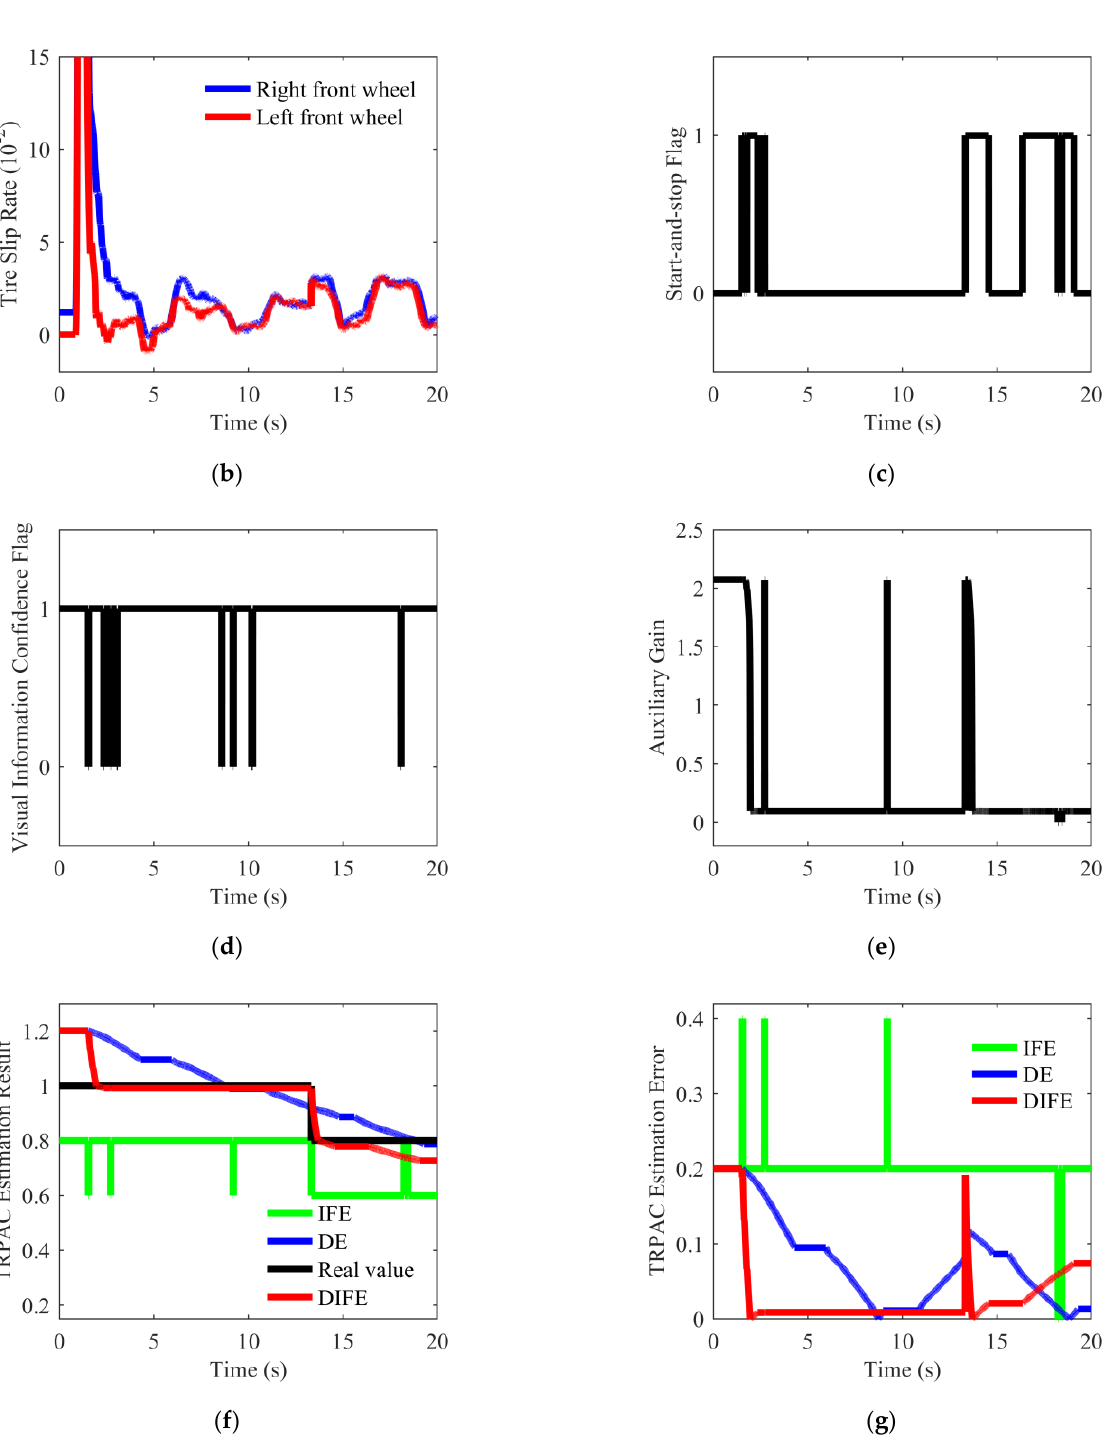
Figure 19. Vehicle test result. ( a ) Vehicle speed; ( b ) Tire slip rate; ( c ) Start-and-stop flag of the DIFE; ( d ) Visual information confidence flag; ( e ) Auxiliary gain of the DIFE; ( f ) Estimation result of different estimators; ( g ) Estimation error of different estimators.